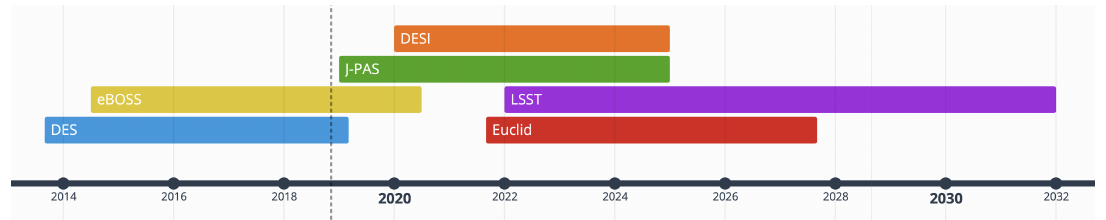
Figure 1. Timeline of the ongoing and upcoming galaxy surveys discussed in Section